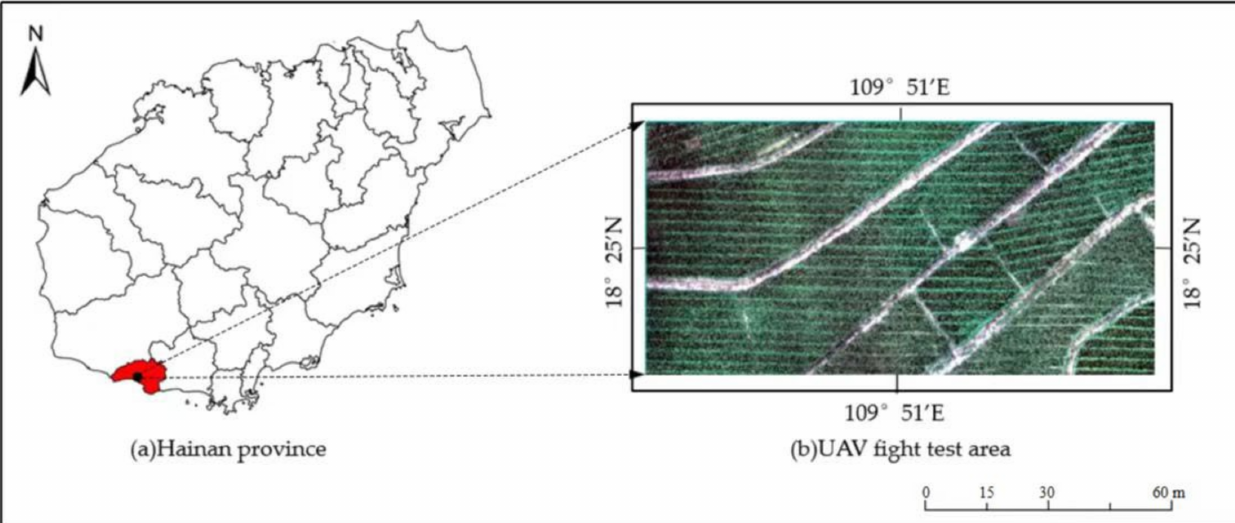
Figure 1. Overview of the experimental site.